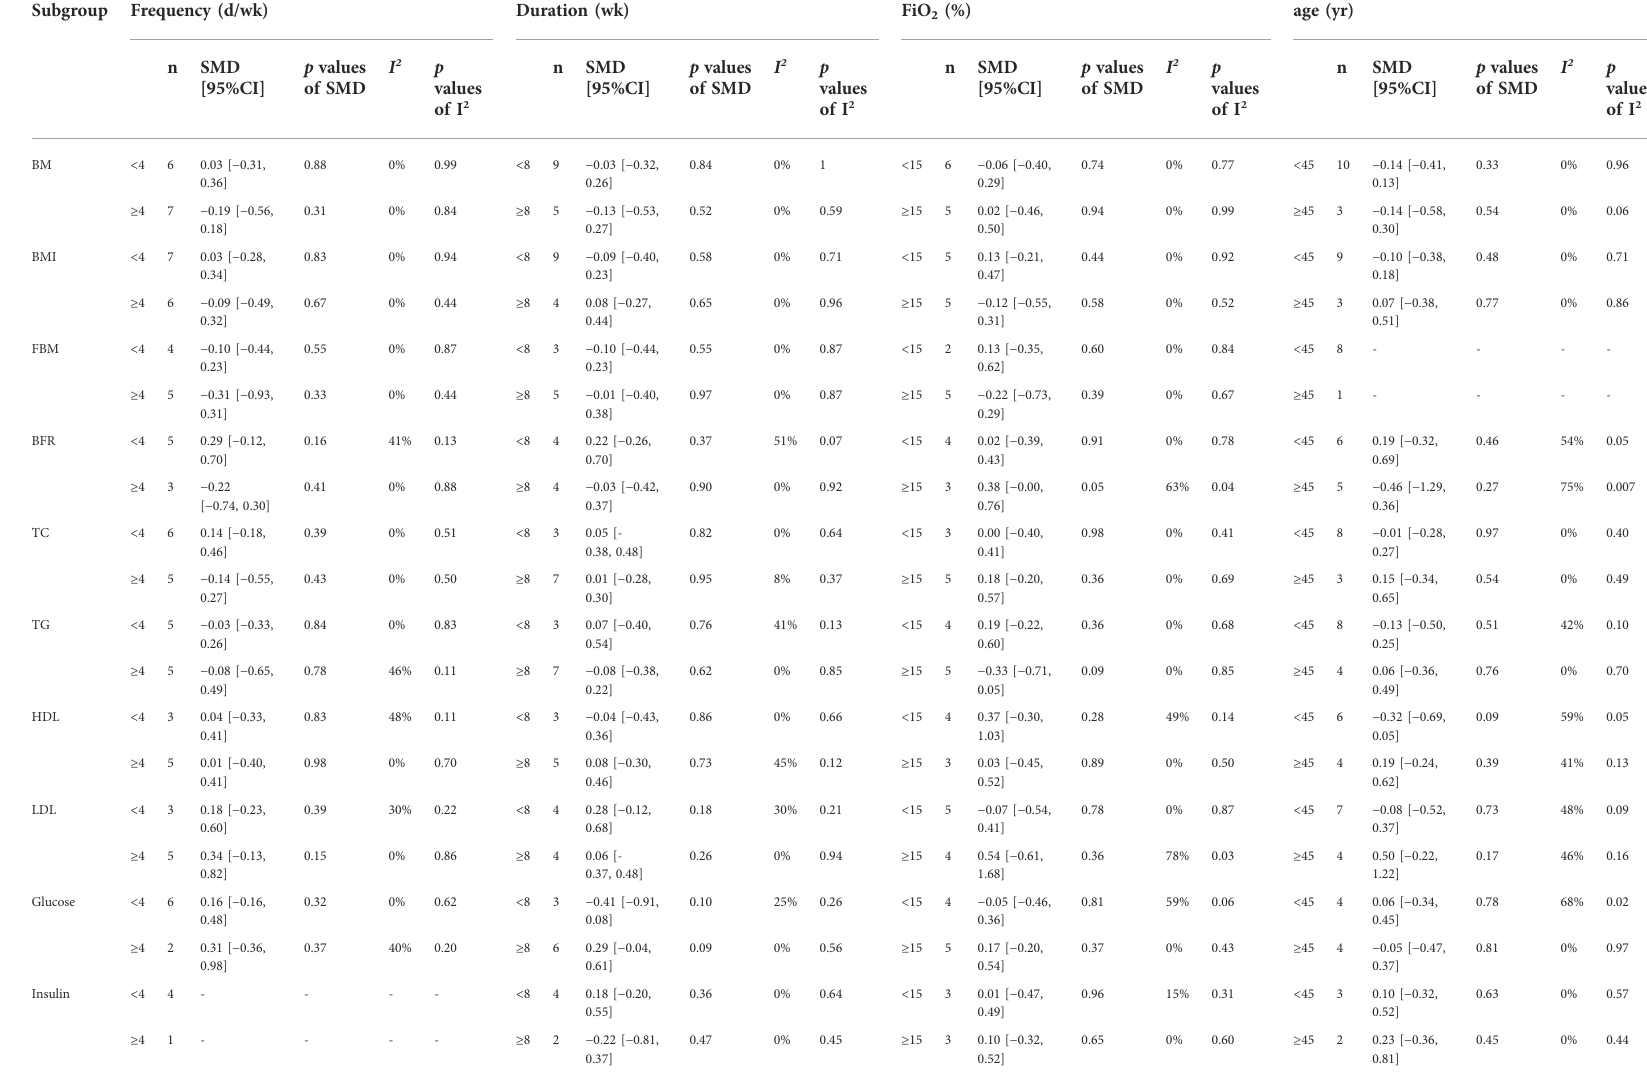
TABLE 2 Subgroup analyses of the effects of exercise training performed in hypoxia versus normoxia on reducing the fat. Subgroup Frequency